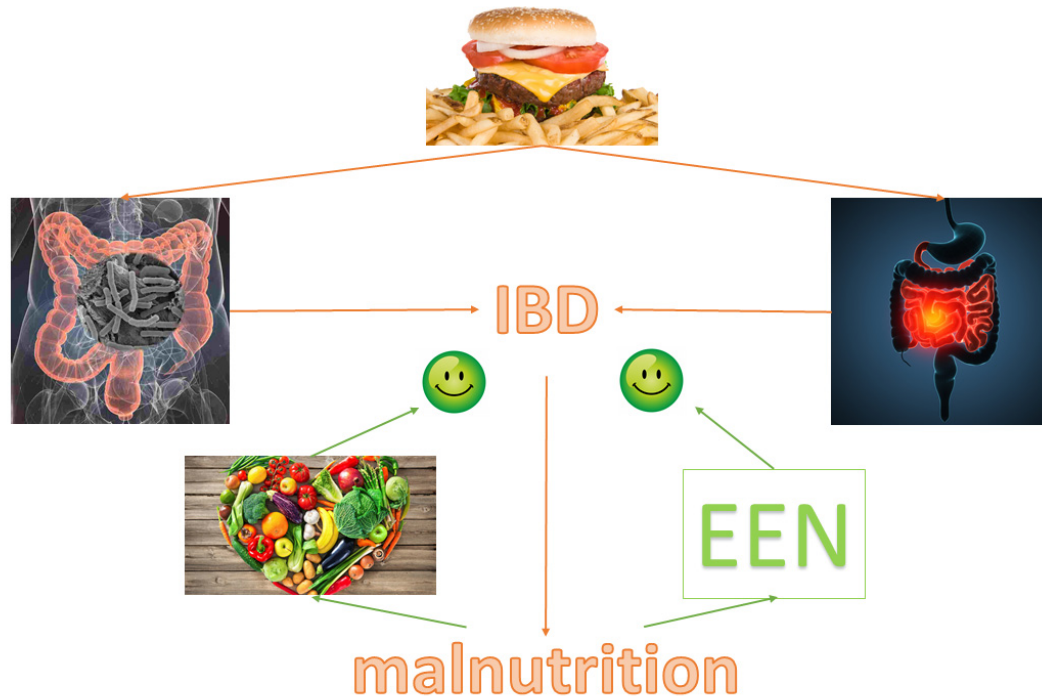
Figure 2. Western diet is a risk fact for inflammatory bowel disease because it causes intestinal dysbiosis and inflammation; one important consequence of inflammatory bowel disease is malnutrition. Micronutrient supplementation and dietary intervention could counterbalance these effects. IBD: inflammatory bowel disease; EEN: exclusive enteral nutrition.